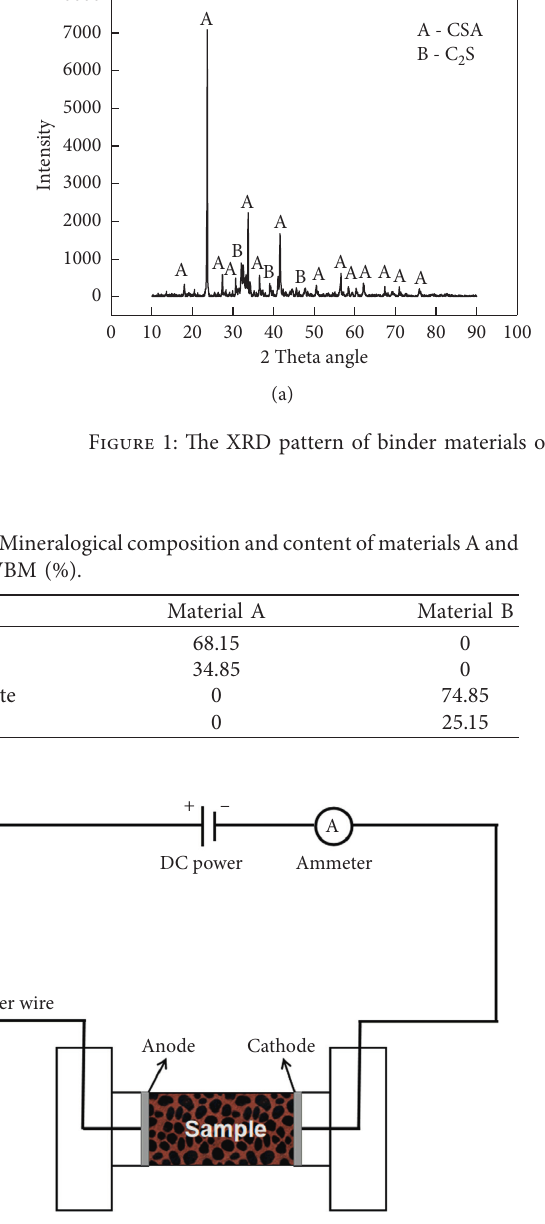
Figure 2: Schematic of the electrochemical treatment applied to the